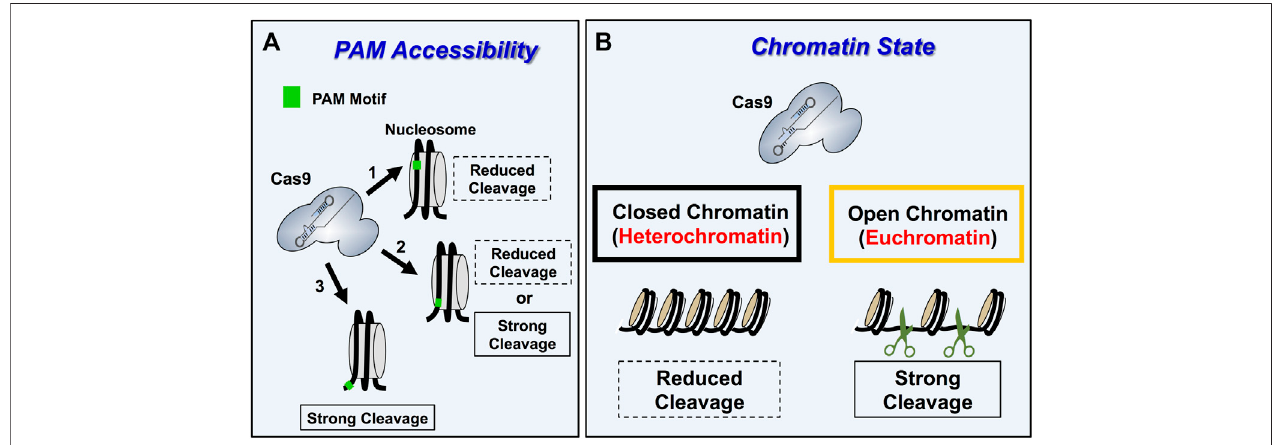
FIGURE 3 | Overview of Cas9 speci fi city and activity in eukaryotic chromatin. (A) Schematic describing the impact of PAM accessibility in nucleosome on Cas9 cleavage dynamics.Nucleosomes occlude Cas9 access toPAM motifs within chromatin reducingCas9 binding and cleavage activity (arrow1). PAM motifs withinlinker DNA, which are located outside the nucleosomes making up the chromatin are accessible and thus get cleaved strongly (arrow 3). PAM motifs located at the entry/exit sites ofnucleosomes(arrow 2) display variable Cas9 activity because Cas9 activity is in fl uenced by PAM orientation and nucleosomebreathingdynamicsfor these PAM positions. Importantly, PAM motifs oriented away from the nucleosome at the entry/exit sites are typically cleaved better than inward facing PAM motifs. (B) Schematic showing how Cas9 targeting ( i.e ., binding and cleavage). is more ef fi cient in open and transcriptionally active euchromatic regions relative to silent, transcriptionally silent heterochromatin regions.